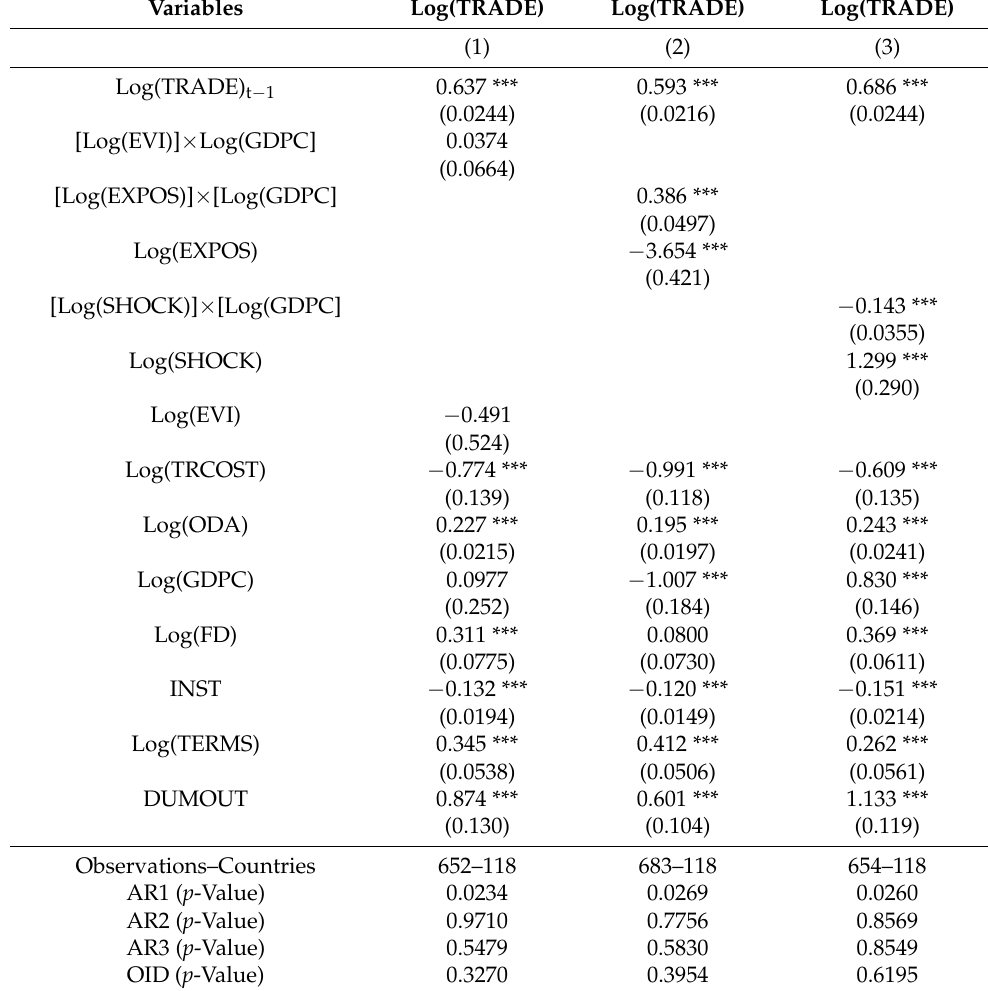
Table 3. Effect of EVI on participation in international trade. Estimator : Two-step System